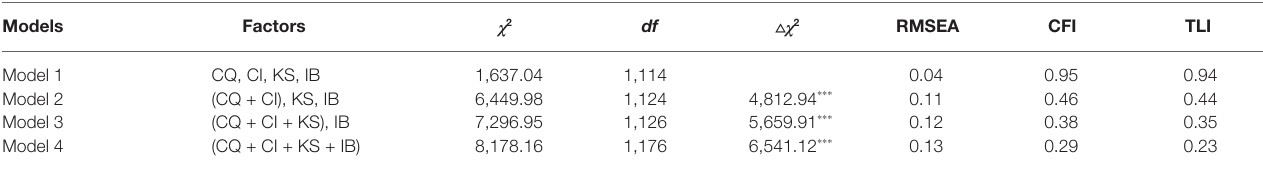
TABLE 1 | Results of confirmatory factor analysis for the study variables.